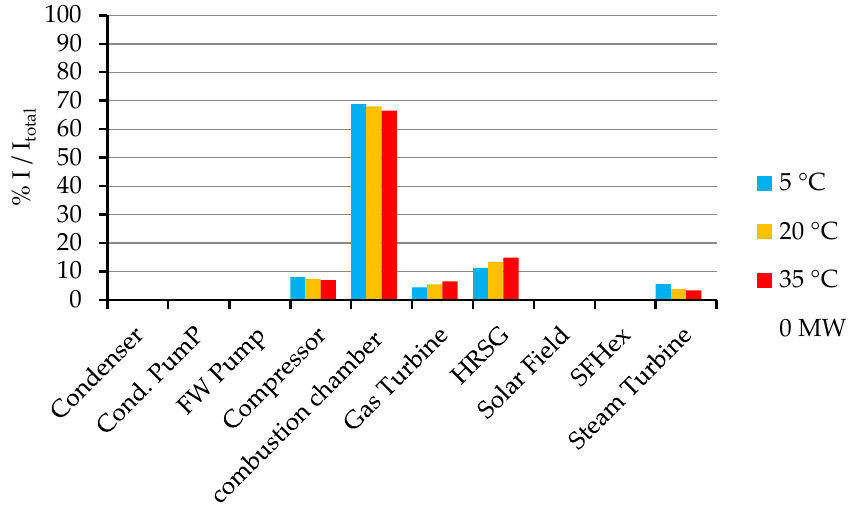
Figure 3. percentage of exergy destruction in each component of the ISCC out of the total exergy destruction of the plant at different ambient temperatures for solar heat input equal to 0 MW.